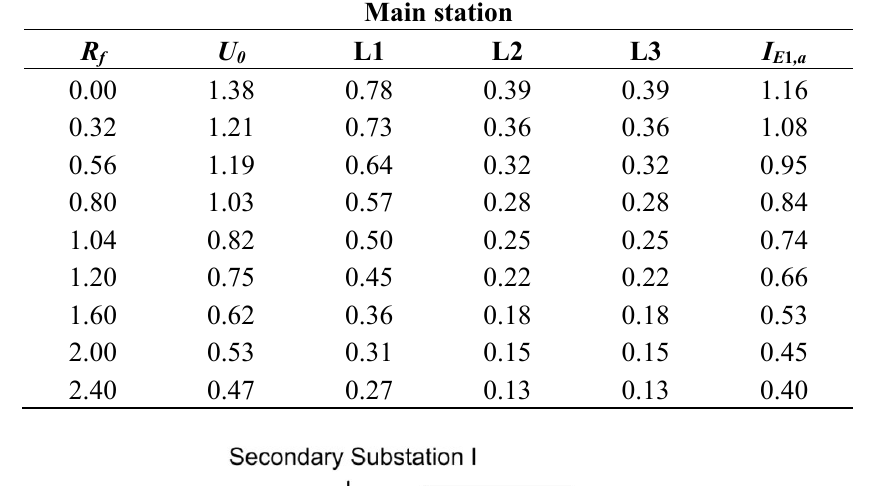
Table 7. Experimental results. Three lines loaded with identical length. Residual current